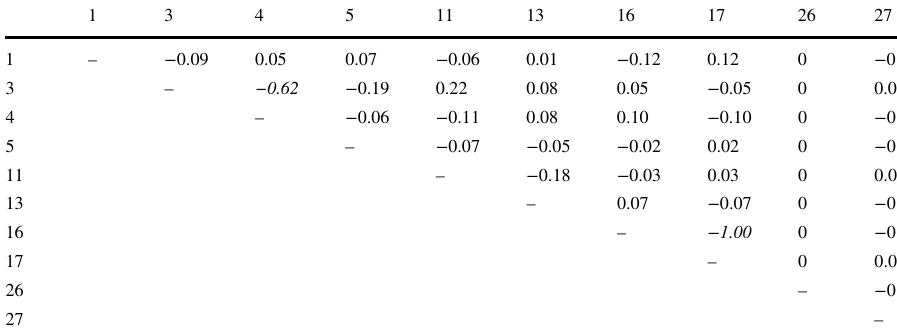
Table 5 Inter-correlation matrix